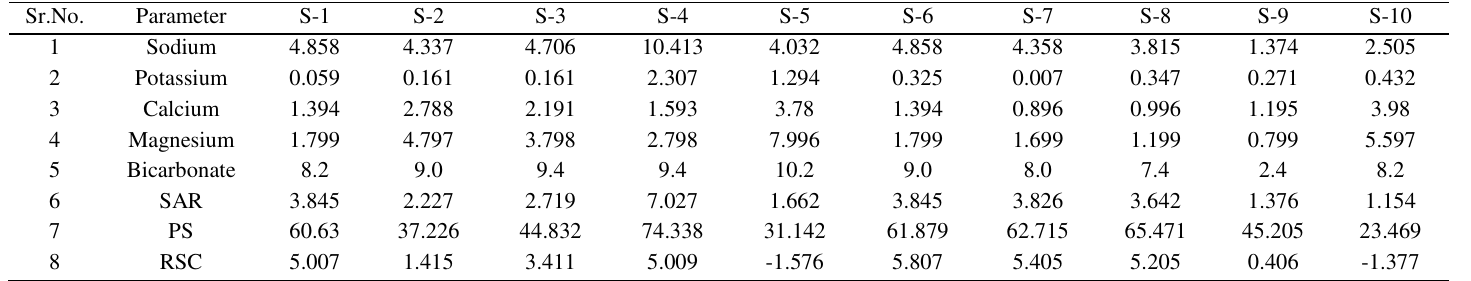
Table-4 Physico-chemical analysis report of Potable waters in AUGUST-2004